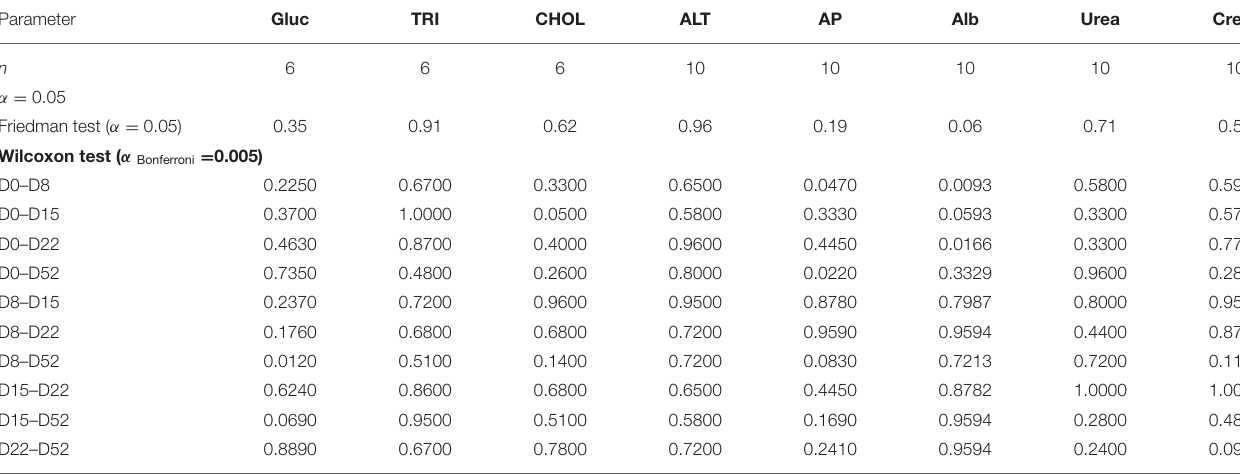
TABLE 6 | Biochemical parameters and respective p values (Friedman and Wilcoxon tests).